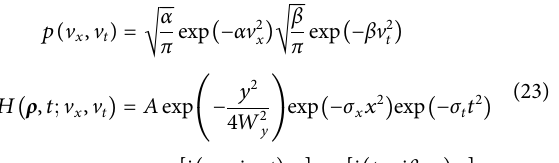
− 1 and Δ v t = 0.1291 ps